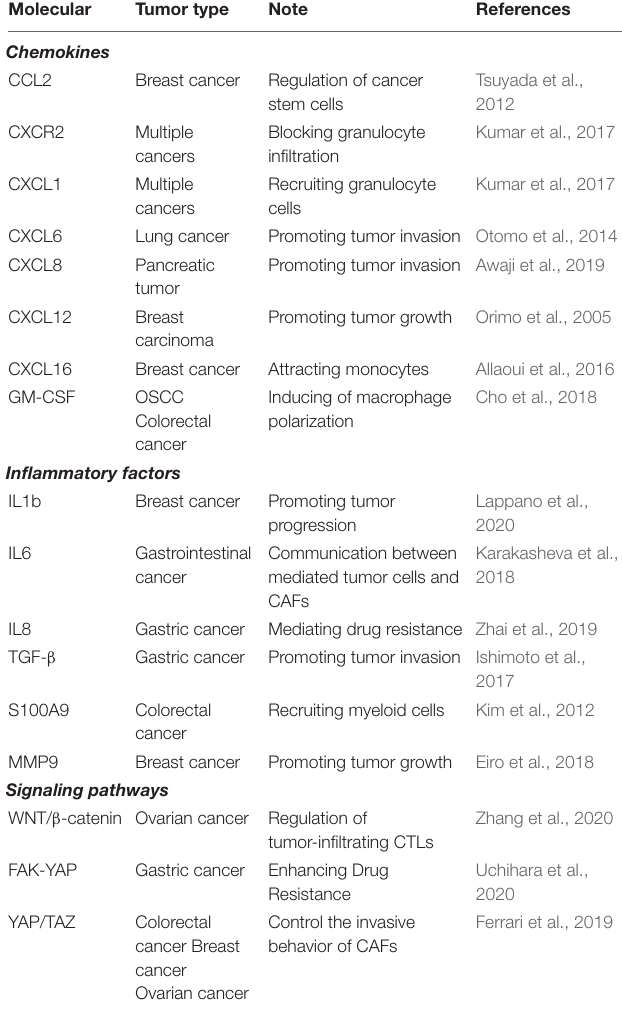
TABLE 1 | Molecules associated with CAFs in a multiplicity of